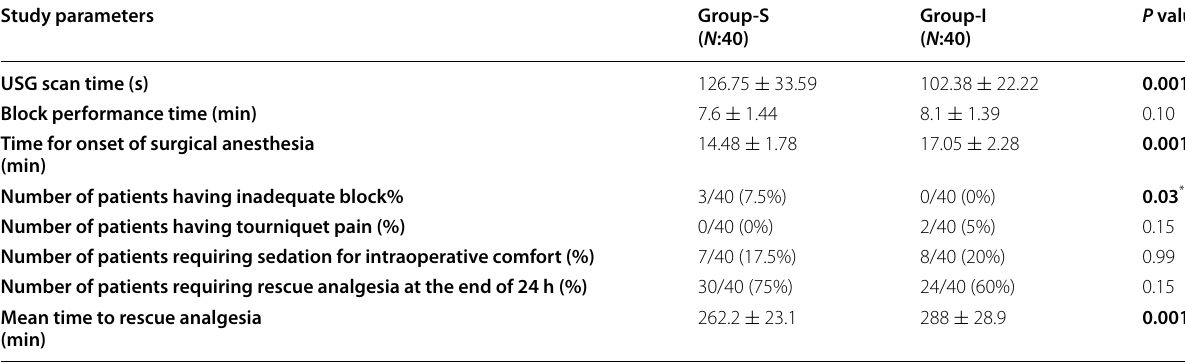
USG scan time, block performance time, time to surgical anesthesia, and mean time to rescue analgesia is presented as mean independent sample Student’s t test. Number of patients having inadequate block, tourniquet pain, requiring sedation were compared using Fisher’s exact test, patients requiring rescue analgesia was compared using chi-square test. * indicates P value is significant